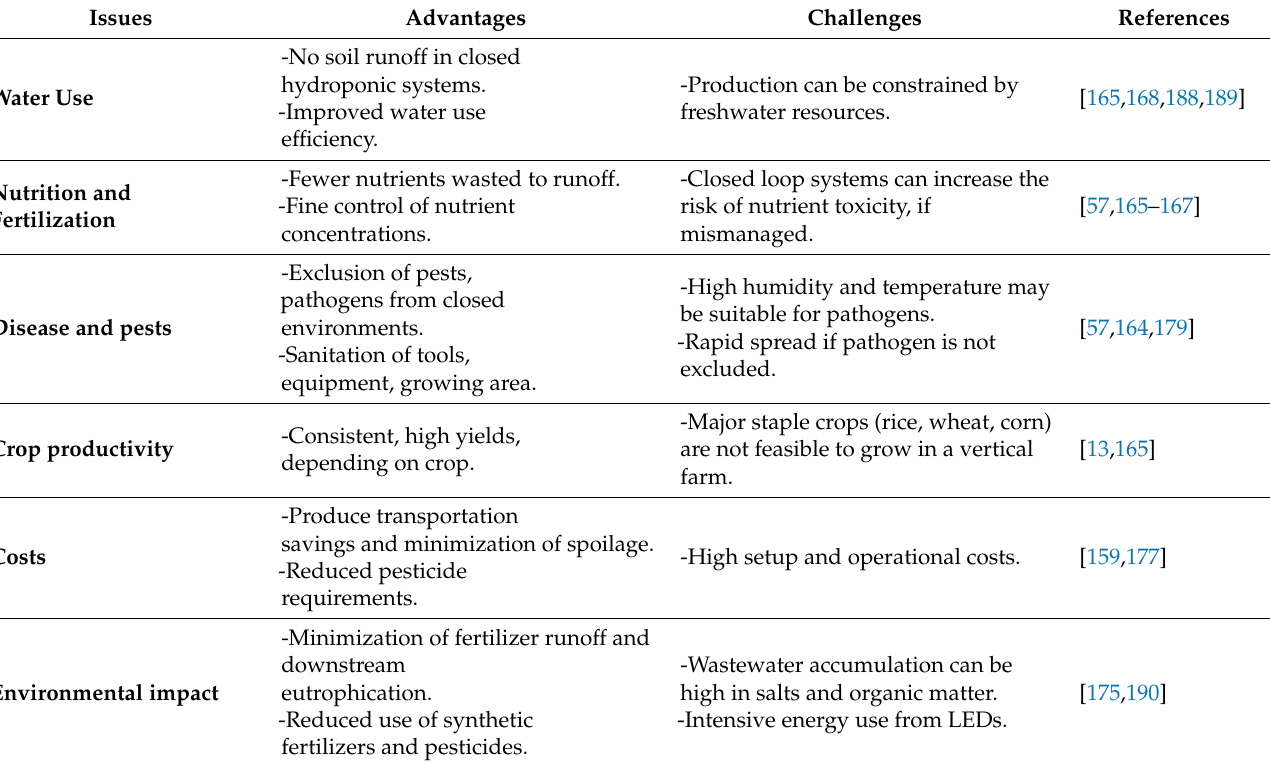
Table 3. Advantages and challenges of vertical farming using a closed-loop